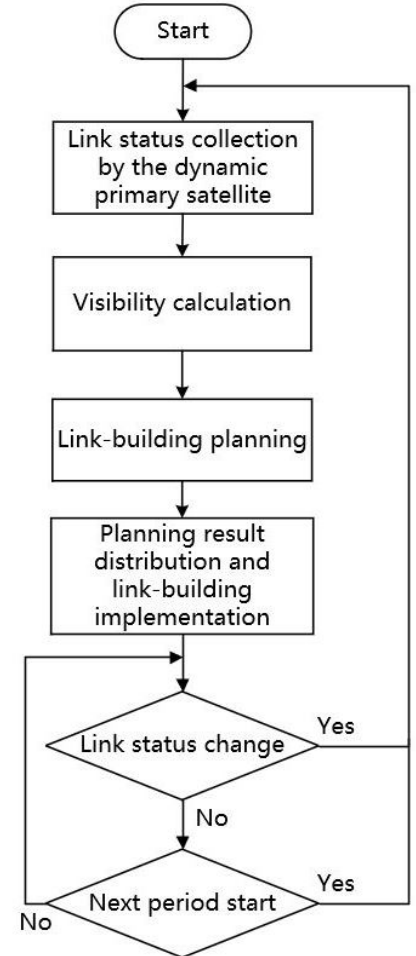
Figure 2. Flow chart of onboard centralized ISL-building planning